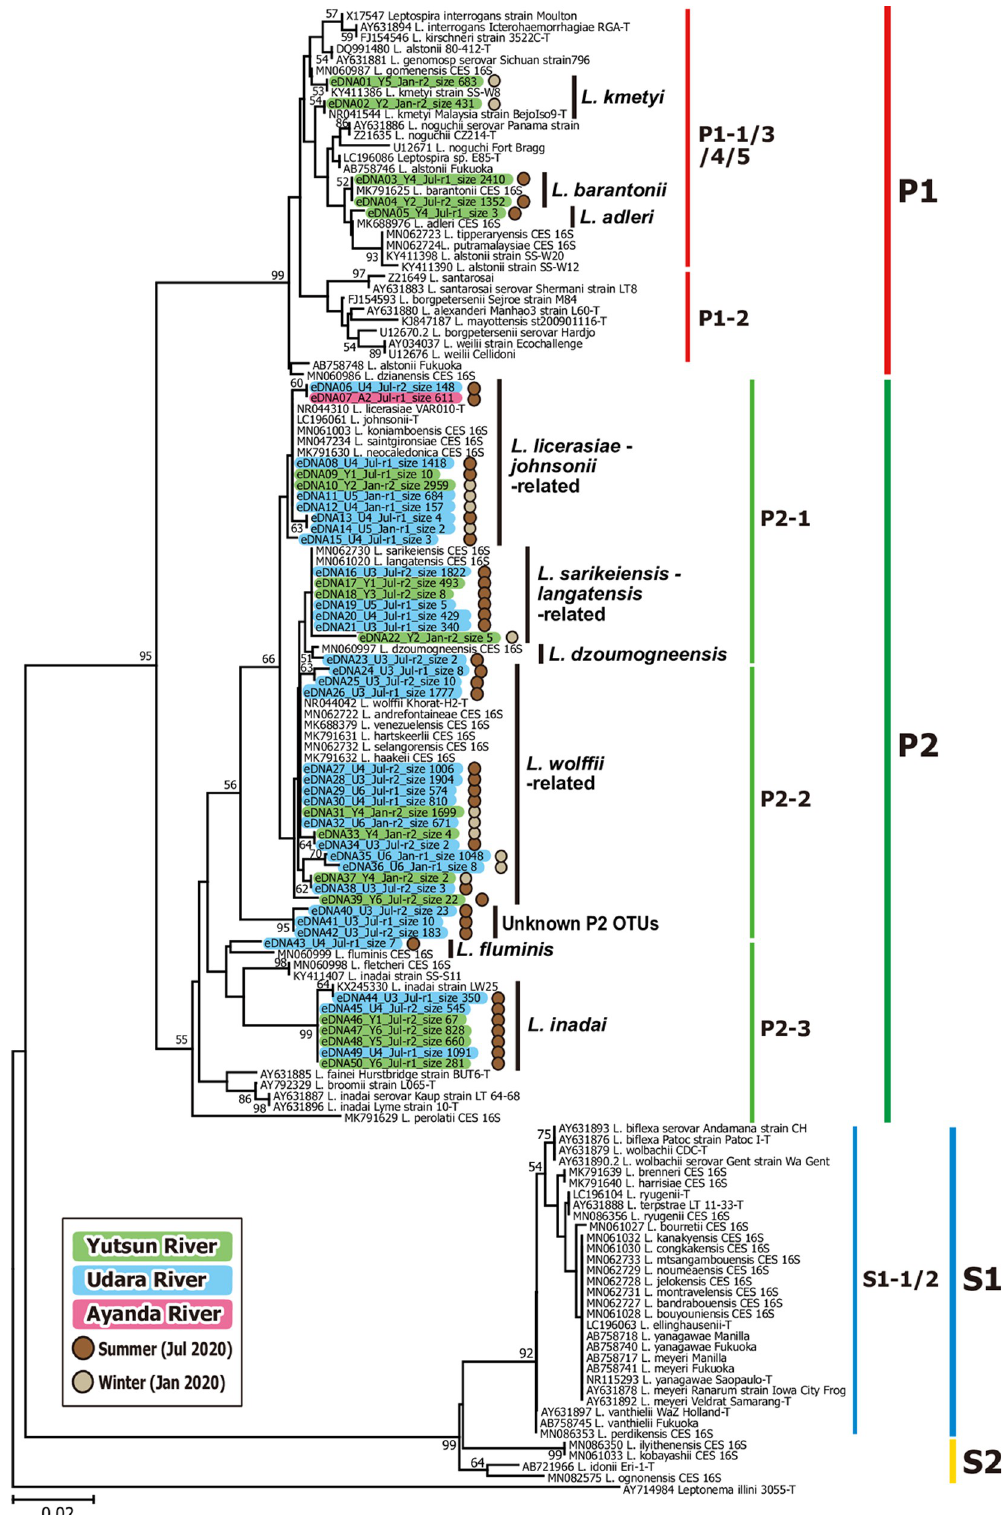
Fig 4. Molecular phylogenetic tree of partial leptospiral 16S rRNA sequences from river water eDNA samples with those of representative Leptospira species. Green, blue, and magenta shading indicate the partial 16S rRNA sequences